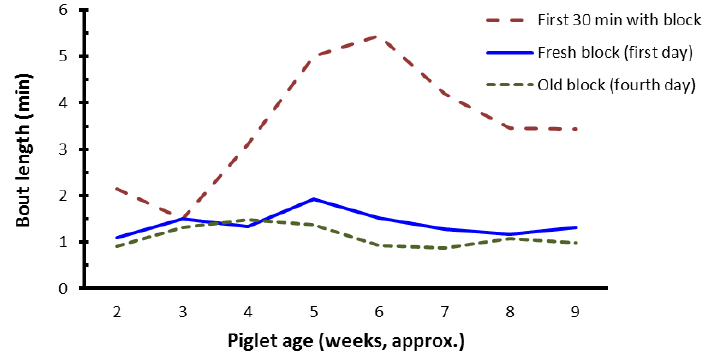
Figure 4. Mean bout length of oro-nasal contact with the shaped blocks by focal pigs in the The data presented are back-transformed mean values, showing bout duration in the first 30 min of placement of a fresh block, the first 24 h and the fourth day after the block was provided. Pigs were weaned at about age 28